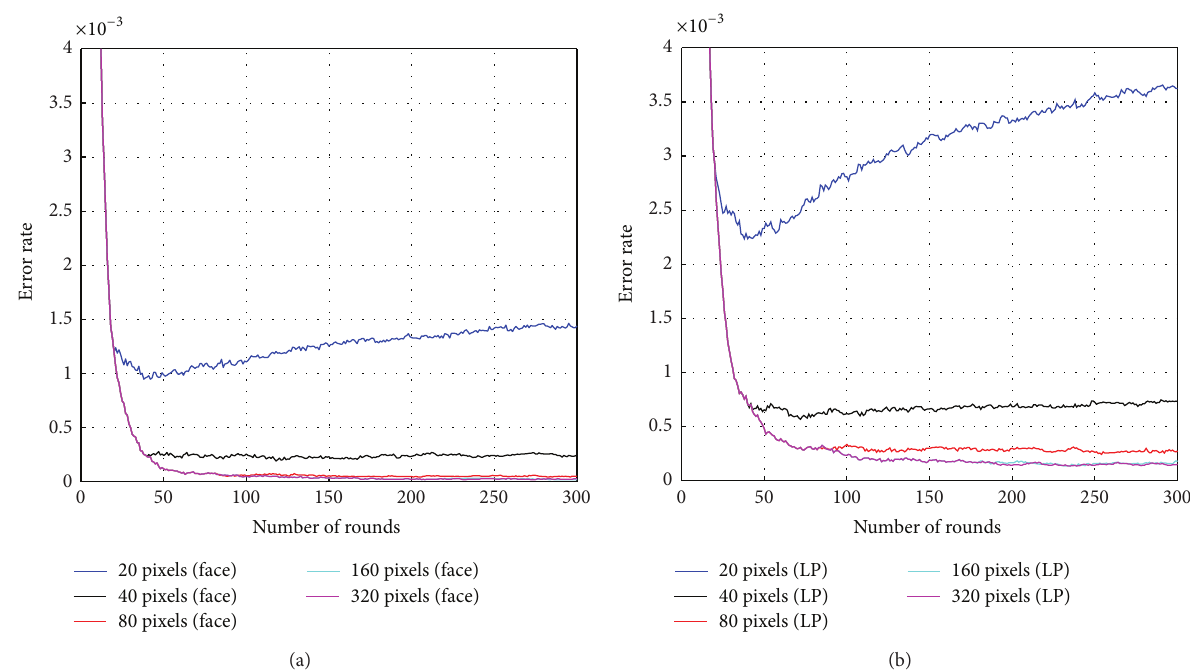
Figure 8: (a) Testing error according to the number of pixel locations on face DB. (b) Testing error according to the number of pixel locations on license plate (LP) DB.